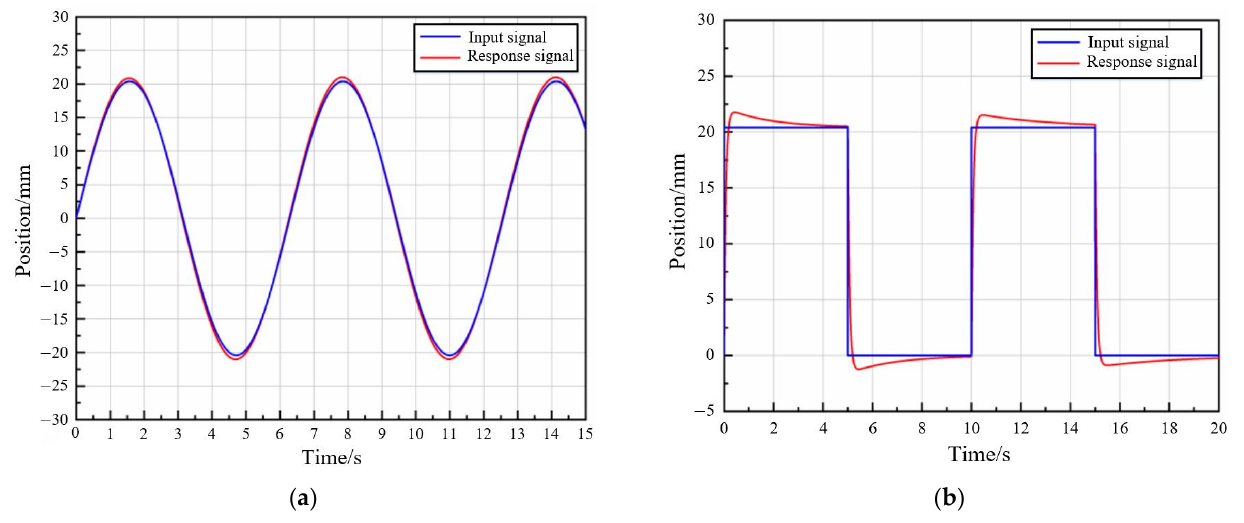
Figure 10. Tracking response of neural network PID control. ( a ) Sine wave tracking simulation; ( b ) Square wave tracking simulation.